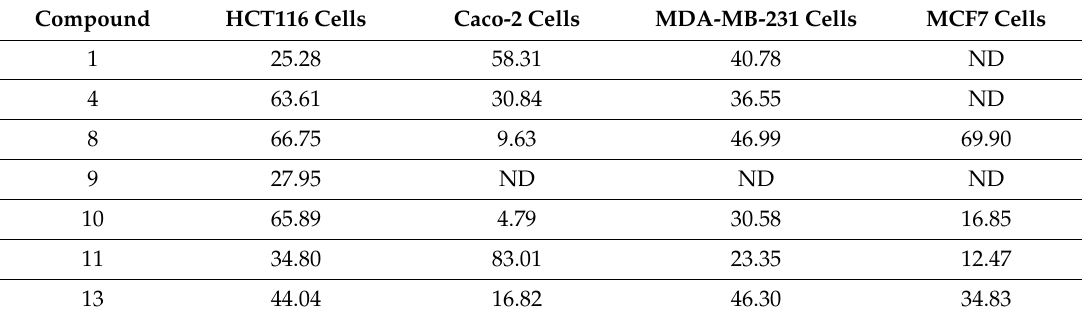
Table 1. IC 50 s of the compounds against different colorectal and breast cancerous cell lines. Compound HCT116 Cells Caco-2 Cells